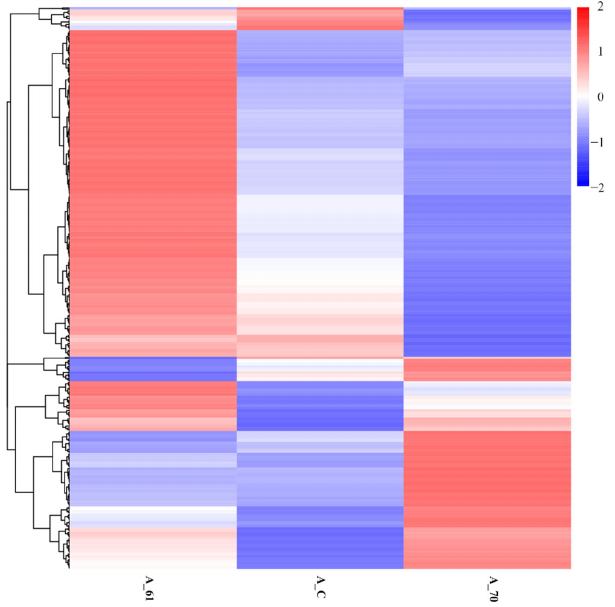
Figure 11. Clustering heatmap of total differential metabolites. The specific metabolite information is provided in Figure S1.